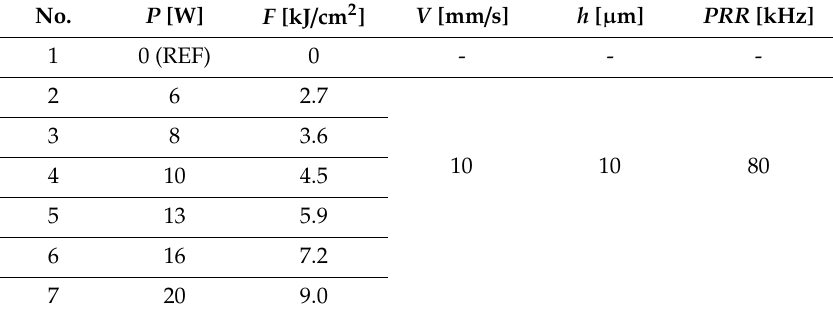
Table 2. Set of process parameters selected for the experiment, where: P —average laser power, F —laser energy density (fluence), V —scanning speed of the sample, h —hatching distance, and PRR —pulse repetition